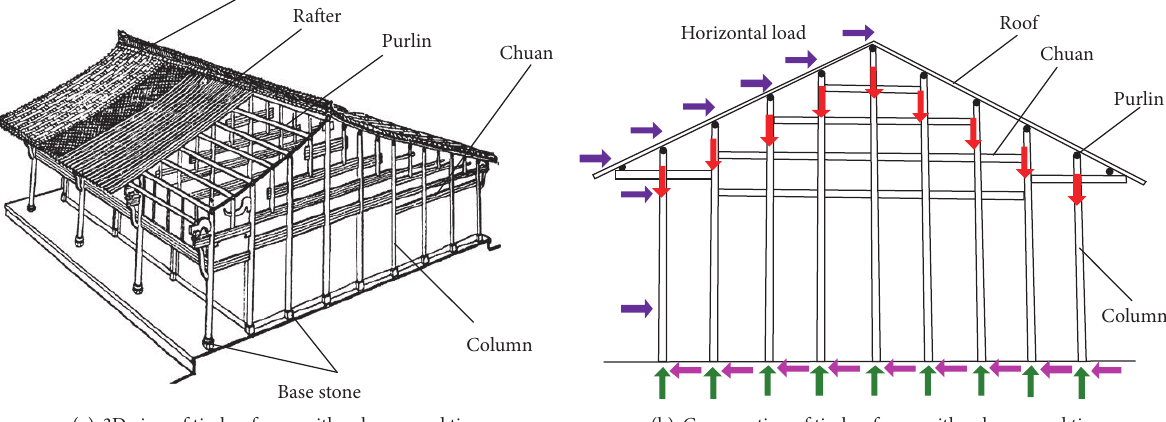
Figure 3: Timber frame with columns and